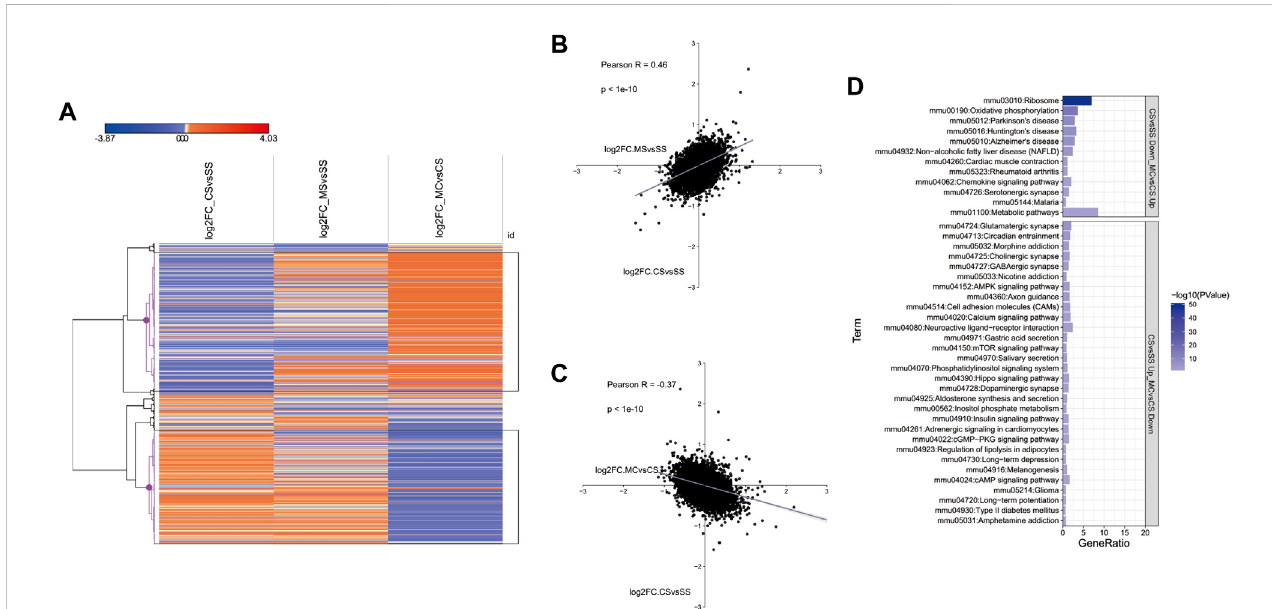
FIGURE 2 Transcriptome-wideresponseofL-methionine(MET)tococaineCPP. (A) Heatmapofallsigni fi cantlydifferentiallyexpressedgenesineachgroup(saline + cocaine [CS], MET + saline [MS], and MET + cocaine [MC]). Red, upregulated; blue, downregulated. (B,C) Scatter plot of DEGs depicting the expression changes between MS and CS (B) and between MC and CS (C) . (D) Enriched pathways of DEGs downregulated in the MC group and upregulated in the CS group, and upregulated in the MC group and downregulated in the CS